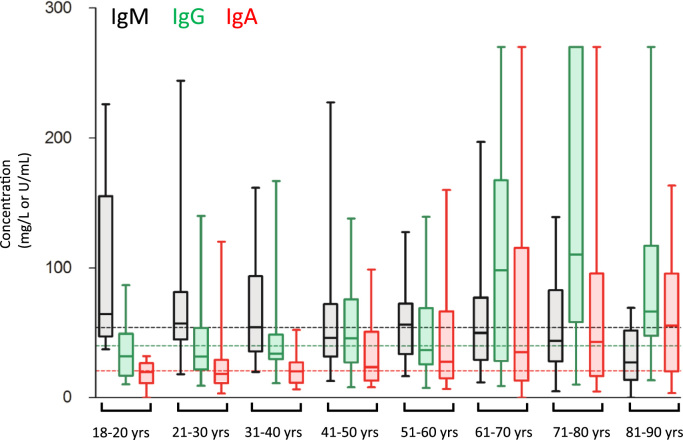
Age-stratified concentrations of PCP IgM (U/mL), IgG (mg/L) and IgA (U/mL) in adult blood donors. Dotted lines represent median concentrations for IgM (54 U/mL; black), IgG (40 mg/L; green) and IgA (21 U/mL; red). Box and Whisker plots show interquartile ranges, median, minimum and maximum concentrations.